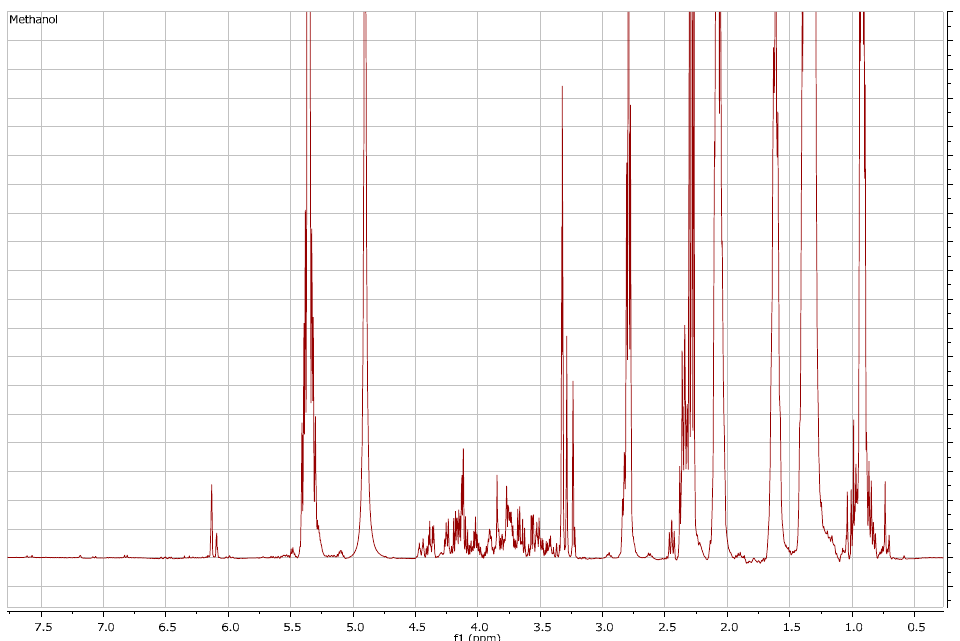
Figure A4 . NMR spectrum of flour extract in Pyridine-d5